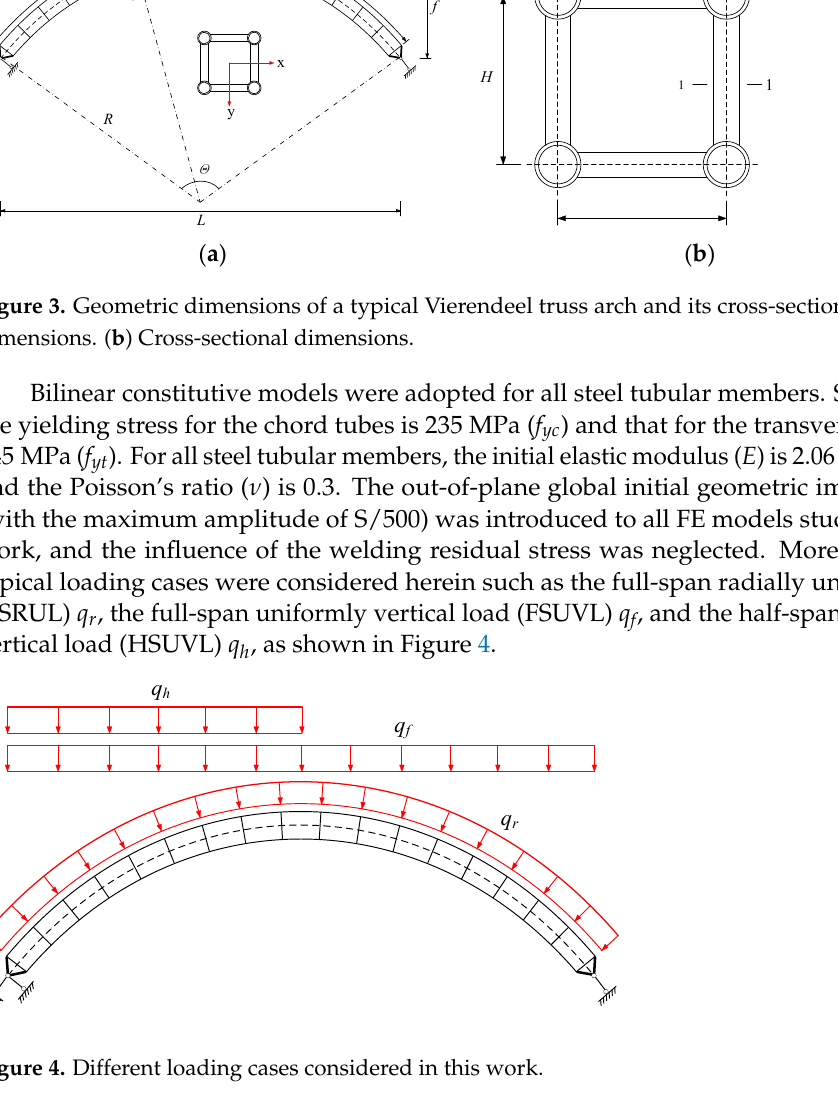
Figure 3. Geometric dimensions of a typical Vierendeel truss arch and its cross-section. ( a ) Global dimensions. ( b ) Cross-sectional dimensions.